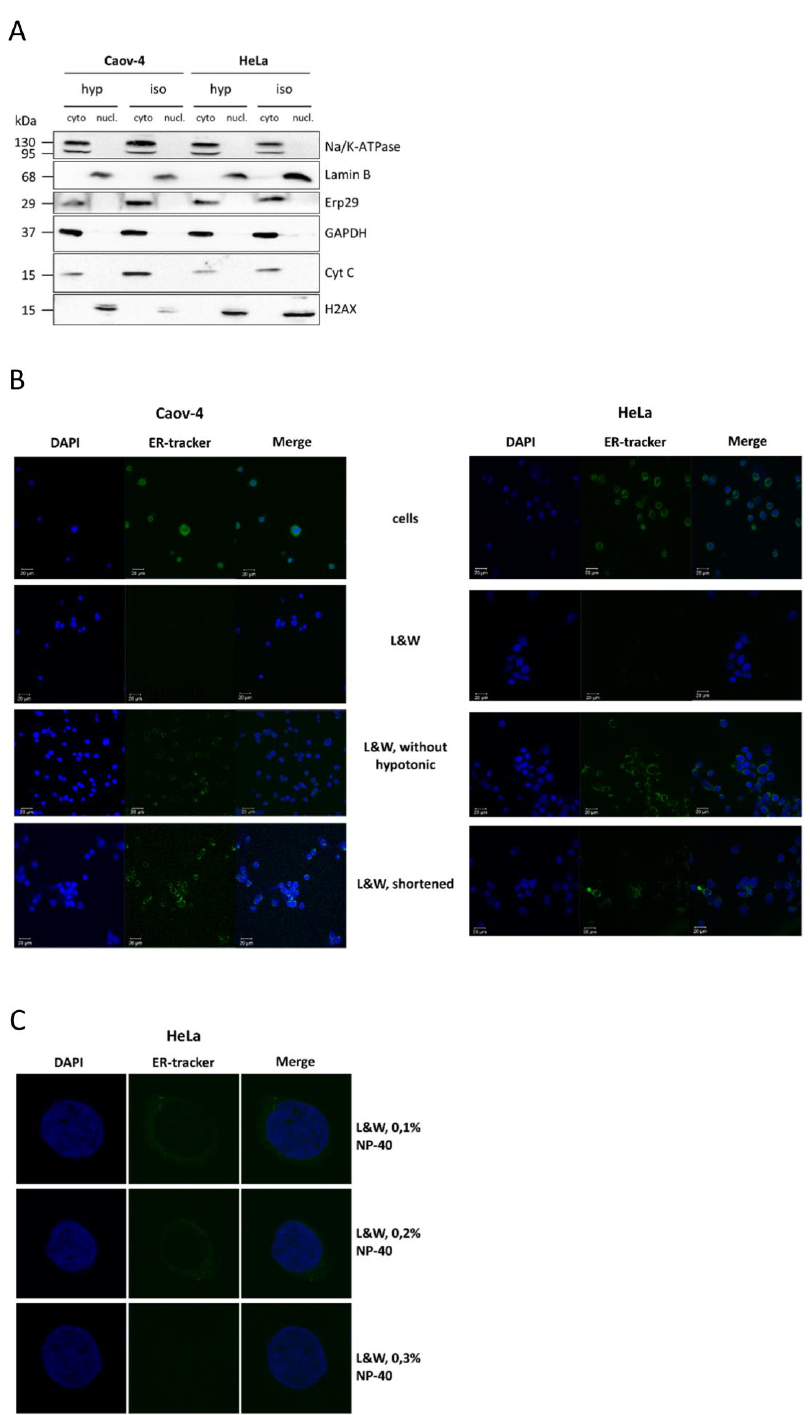
Figure 1. Optimization of the Lyse-and-Wash (L&W) nucleus/cytoplasm fractionation protocol. ( A ) Western Blot analysis of cytoplasmic and nuclear fractions from Caov-4 and HeLa cells obtained by the L&W approach with (hypo) or without (iso) pre-incubation of cells in a hypotonic buffer before lysis. Markers of the cell membrane (Na/K ATPase), ER (ERp-29), mitochondria (cyTable 2. AX) were used to control fractionation quality; ( B ) confocal microscopy of nuclei from Caov-4 and HeLa cells isolated by the L&W approach and its modifications, without pre-incubation of cells in hypotonic buffer or with shortened steps. The samples were stained with DAPI and ER-tracker; ( C ) confocal microscopy of nuclei from HeLa